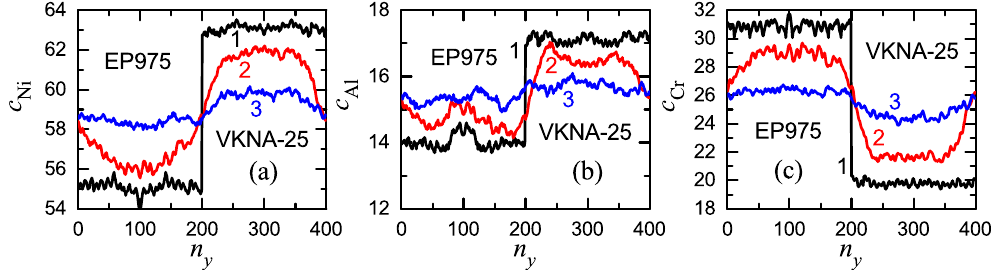
Figure 4. Distribution of concentrations of elements in at.% along the y direction for ( a ) Ni, ( b ) Al and ( c ) Cr. The concentration profiles are presented for t = 0 (black lines 1), t = 4.5 × 10 10 (red lines 2) and t = 3.0 × 10 11 (blue lines 3).